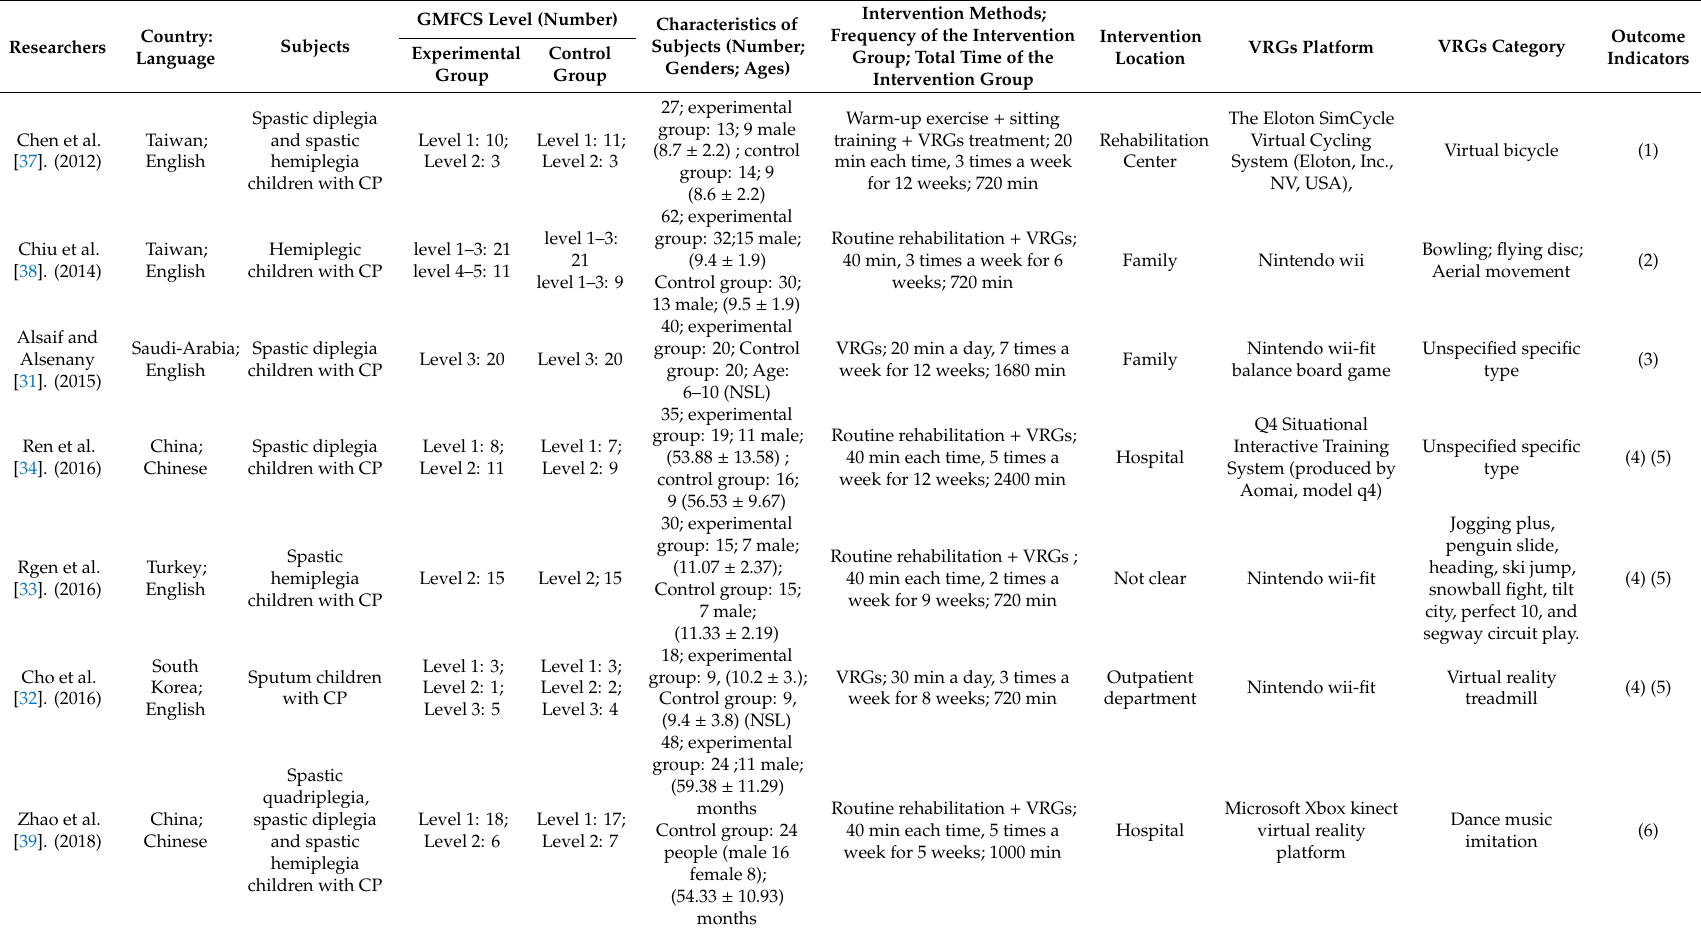
Table 1. List of basic characteristics of the included